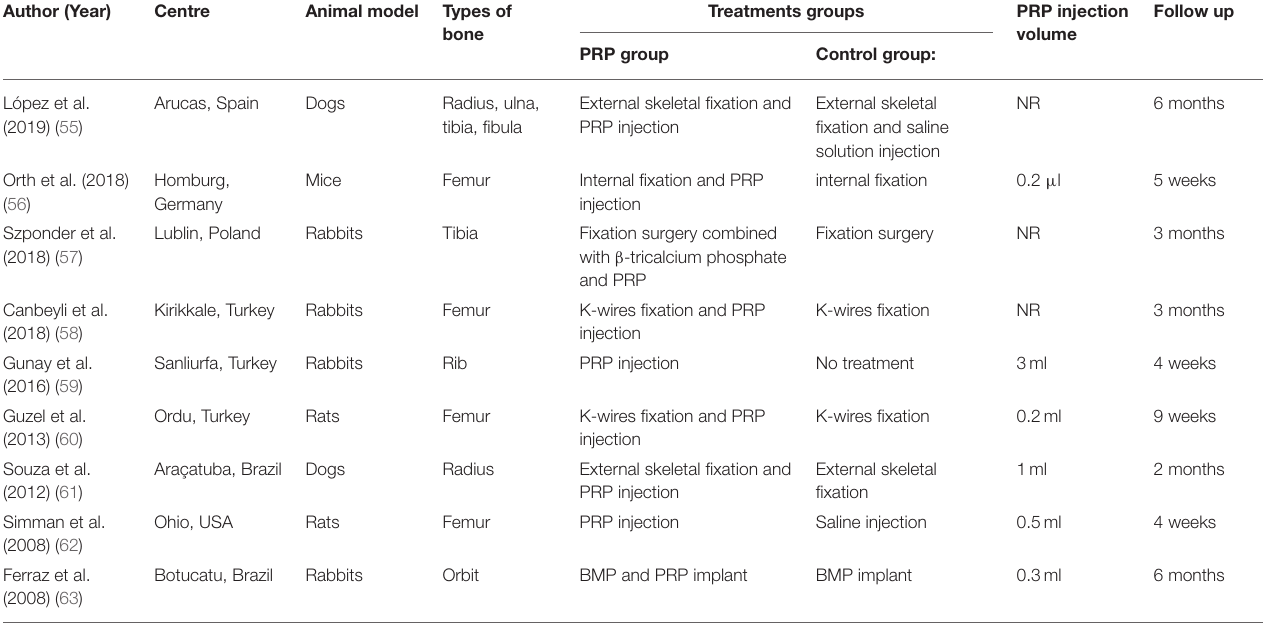
TABLE 2 | The main details of animal